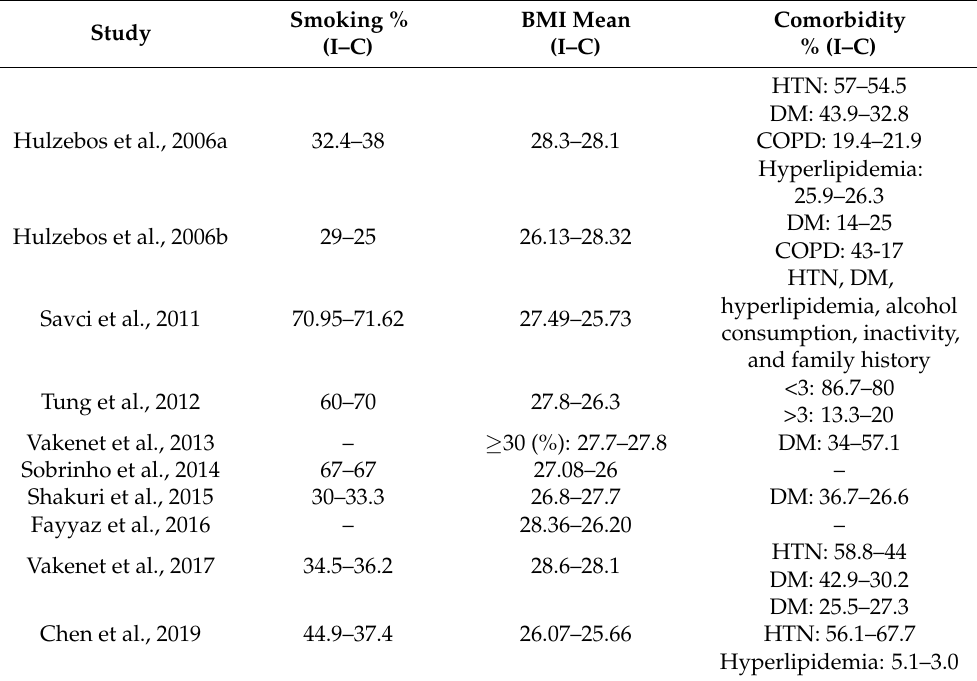
Table 3. The risk factors and comorbidities of patients included in the